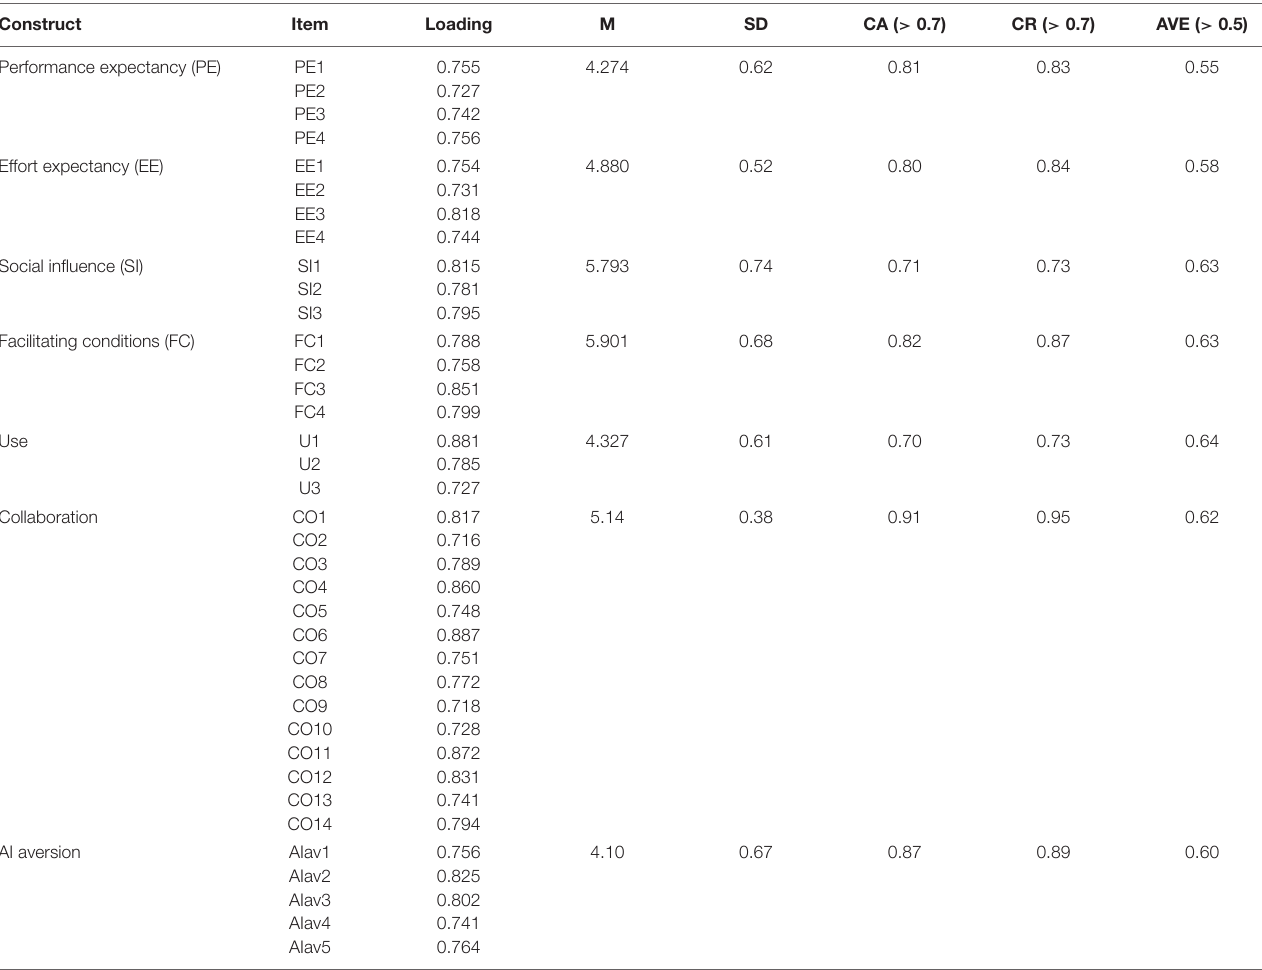
TABLE 2 | Mean, standard deviation, loading, Cronbach’s alpha, CR, and